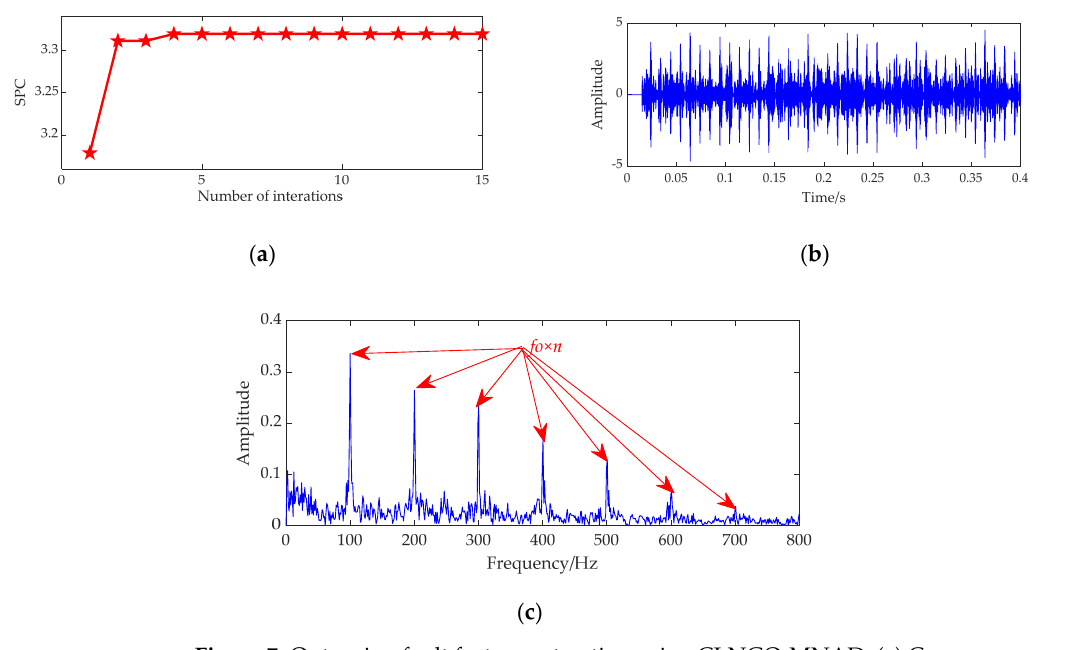
Figure 7 . Outer ring fault feature extraction using CLNGO-MNAD . ( a ) Convergence curve of SPC. ( b ) Time-domain waveform. ( c ) Envelope spectrum.